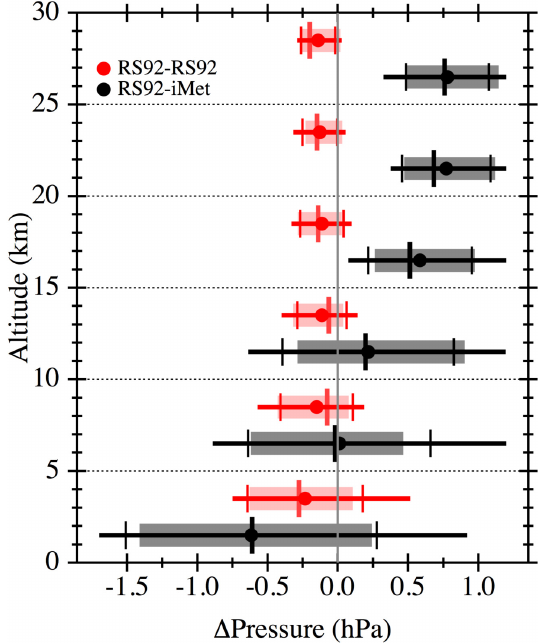
Fig. 10. Profiles of 1 RH for 14 pairs of RS92 sondes, of which 3 are anomalous. Only 5% of 1 RH (open circles) exceed the manufacturer-quoted limits of ± 2%RH (1 σ ) for measurement re- producibility. The lighter and darker red horizontal bars depict the inner-90% ranges and interquartile ranges, respectively, of RS92 RH measurements in 1-km altitude bins, referenced to the top axis scale. These data illustrate how RH values become very small above ∼ 20km. With 95% of RH < 3%RH above 20km, 1 RH are con- strained to be small so these high-altitude data are excluded from the difference